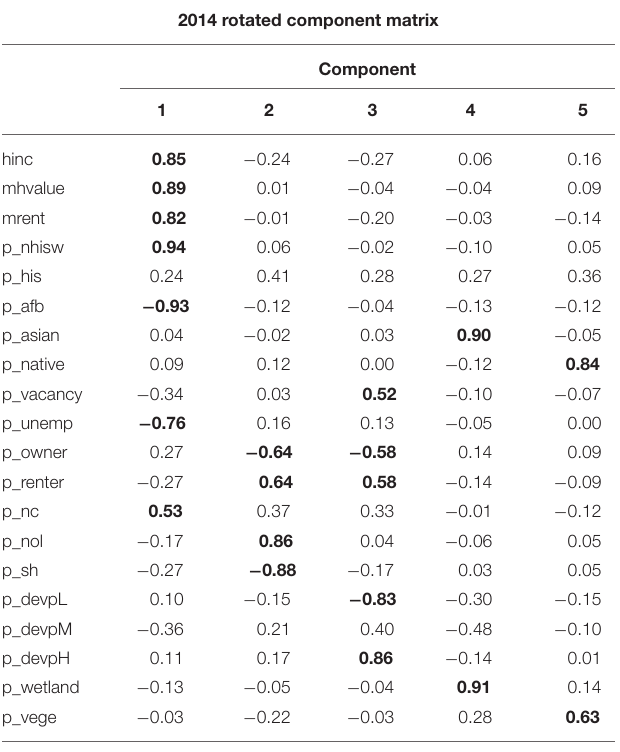
TABLE 8 | Results of principal component analysis using data from year 2014. 2014 rotated component matrix